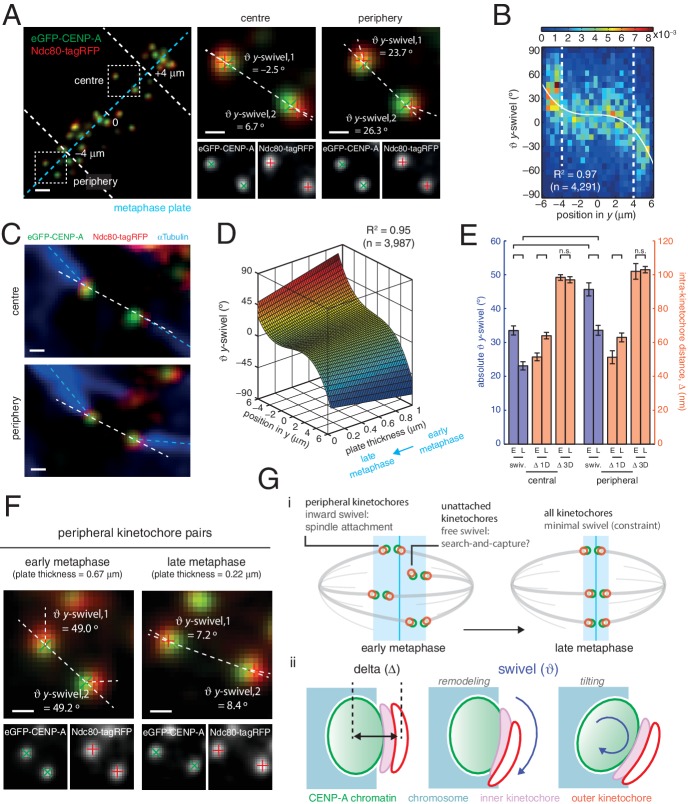
Spatial and temporal control of kinetochore swivel.(A) Kinetochore pairs in centre (centre) and periphery (right) from a metaphase plate (left) showing Gaussian-fitted spot centres, ϑy-swivel, sister-sister axis and marker-marker axis. (B) 2D histogram of ϑy-swivel vs. spindle position in y (n = 4291). White dashed lines divide spindle into the central and peripheral regions, separated at 4 µm. White curve is best-fit degree-3 polynomial, with coefficient of determination, R2 = 0.97. (C) Pairs of sister kinetochores expressing eGFP-CENP-A, Ndc80-tagRFP and stained with αTubulin antibodies. (D) Best-fit sheet through ϑy-swivel against spindle position in y (degree-3 polynomial) and metaphase plate thickness (degree-1 polynomial; n = 3987), with coefficient of determination, R2 = 0.95. (E) Absolute ϑy-swivel (blue, left axis), and Δ 1D and Δ 3D (gold, right axis), for central and peripheral kinetochores for early (> 0.65) and late (< 0.45) metaphase (E, L, respectively) as determined by plate thickness. Statistical tests were significant (p < 10–4) except where n.s. (no significance) is stated. Values are given in Figure 4—source data 1. (F) Examples of kinetochore pairs at spindle periphery during early (left) and late (right) metaphase. (G) (i) Schematic of dependency of swivel on spatial position, attachment status, and progression through metaphase towards anaphase onset. Light blue box indicates thickness of the metaphase plate. (ii) Mechanical degrees of freedom in kinetochore include changes in intra-kinetochore distance (delta; ∆ – black arrow) and swivelling (ϑ – blue arrows), which may involve remodelling of the kinetochore domains and/or tilting of the entire kinetochore structure within the chromosome. All scale bars 500 nm.DOI:
http://dx.doi.org/10.7554/eLife.16159.01510.7554/eLife.16159.016Figure 4—source data 1.Swivel decrease is partnered by an increase in 1D at anaphase onset, but 3D is invariant.Median and standard error values for the bar plots in Figure 4E of ϑy-swivel and 1D (left) and 3D (right) measurements of Δ, comparing kinetochore pairs during early and late metaphase, shown in Figure 4E. ϑy-swivel and Δ 1D significantly increase and decrease, respectively, however 3D does not change.